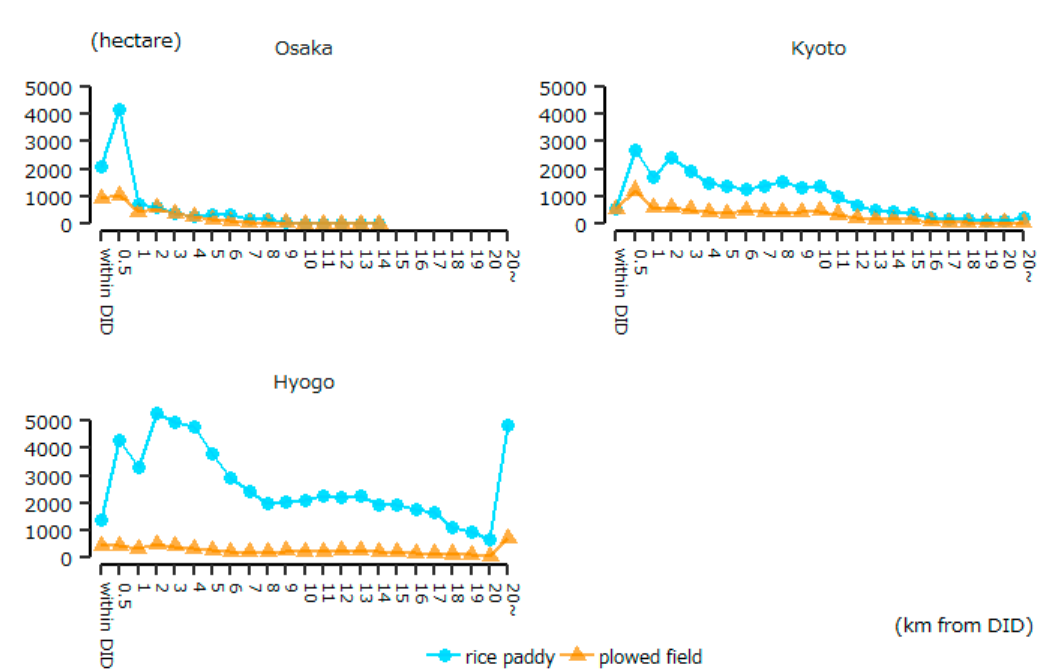
Figure 6. Total areas of each prefecture by distance from DID.